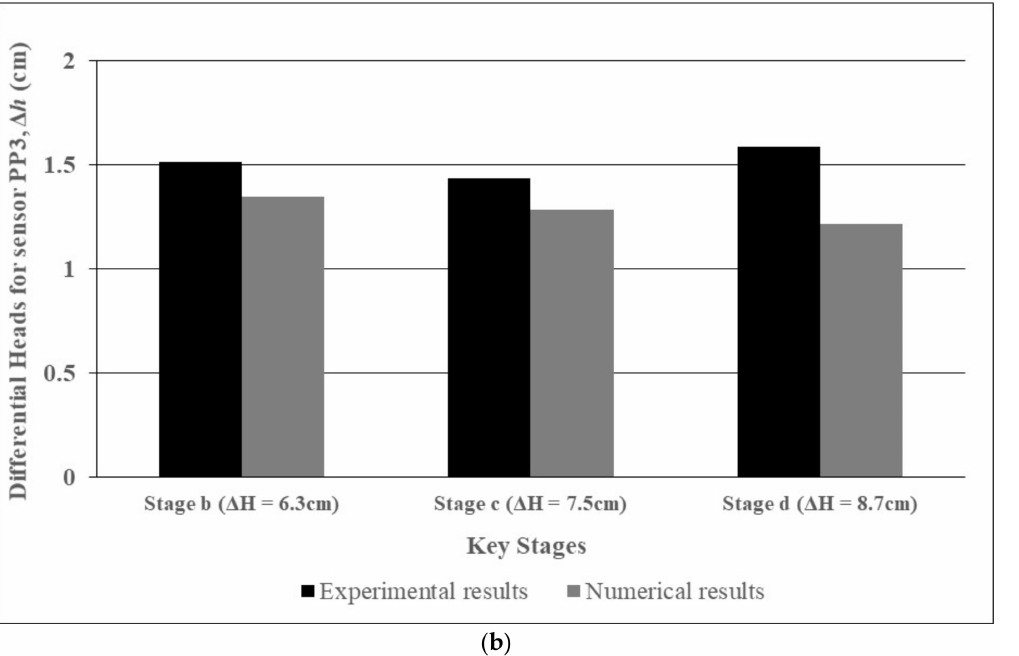
Figure 11. Test data for graded angular sand: ( a ) sketches of BEP development from video at key stages; ( b ) plot comparing measured pore pressures versus numerical results for sensor PP3 in three key stages for graded angular